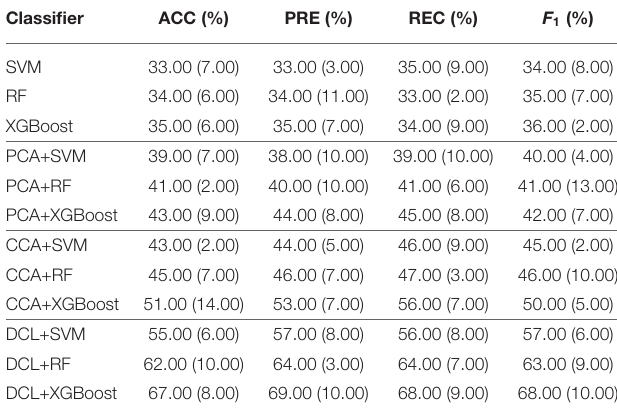
TABLE 6 | Mean values in the evaluation of the classification performance on the subset of